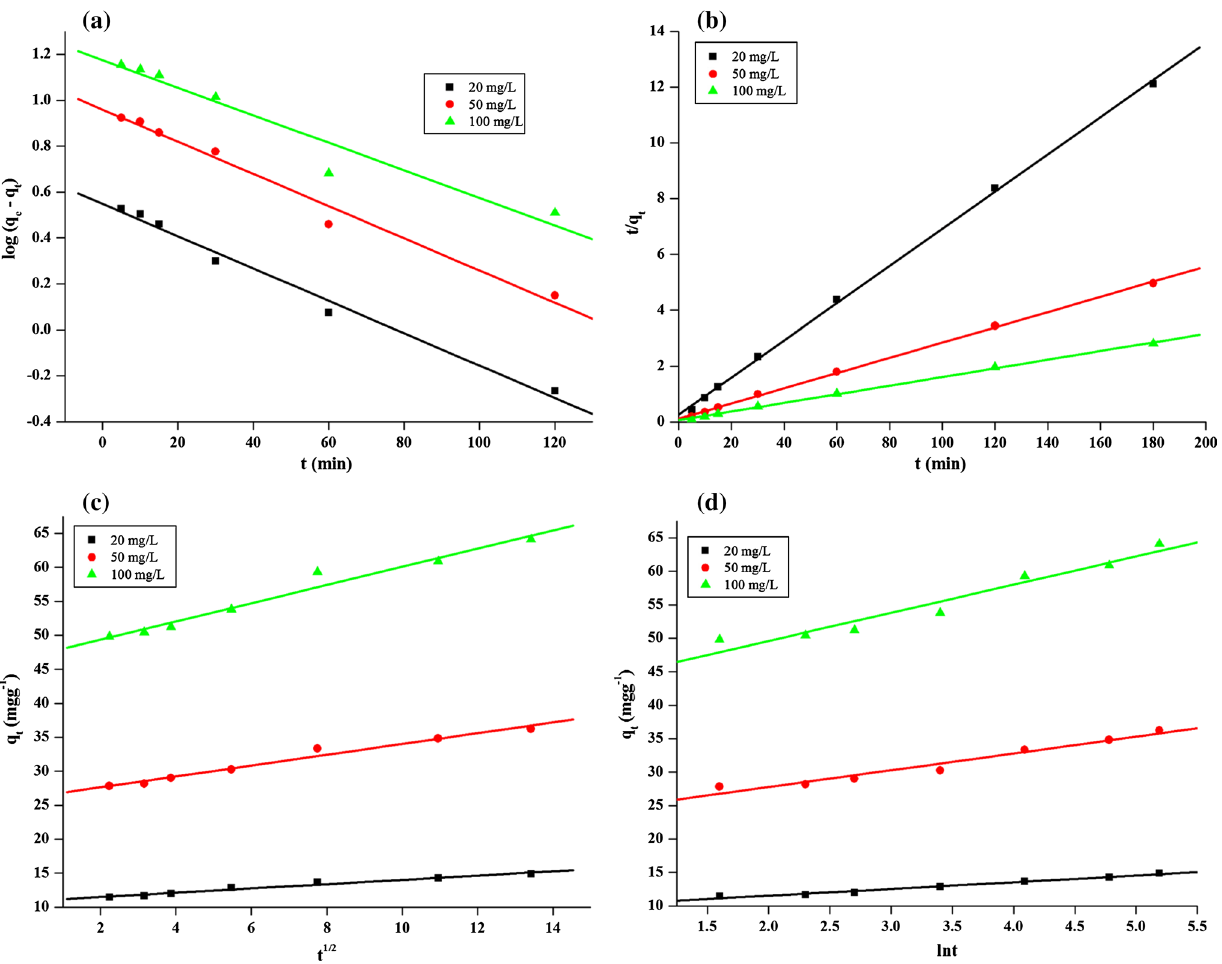
Fig. 10 Adsorption kinetics a pseudo-first order b pseudo-second order c Intra-particle diffusion (d) Elovich for the adsorption of CV onto PGADP at different concentration